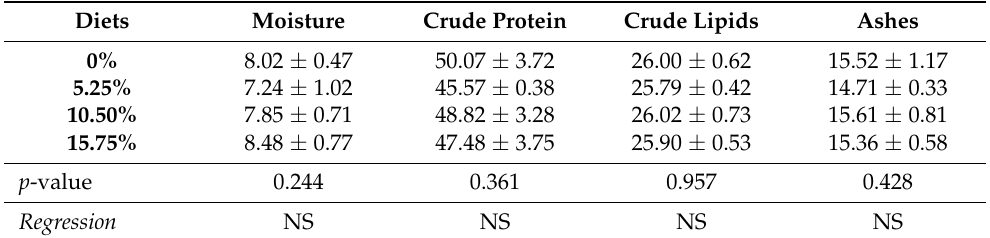
Table 6. Proximate composition of whole body of tambaqui fed diets containing graded levels of full-fat black soldier fly larvae (FF-BSFL) meal for 60 days.